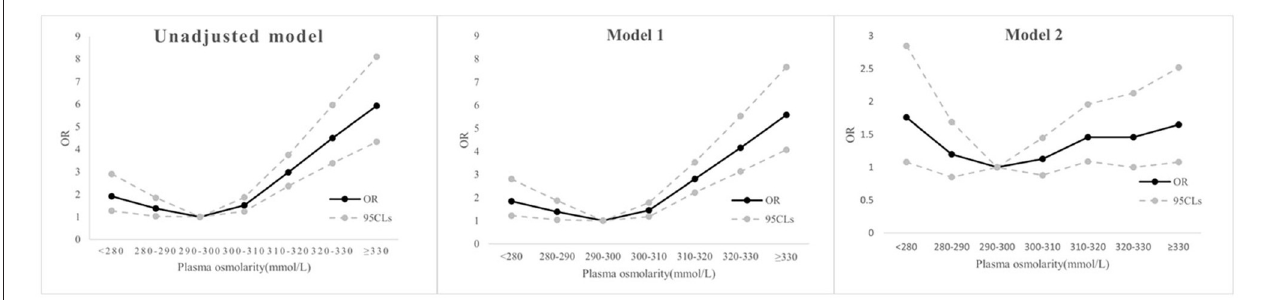
FIGURE 3 | Line graphs reflecting the trend of change in OR of in-hospital mortality in unadjusted model, model 1, and model 2. OR, odds ratio; CI, confidence